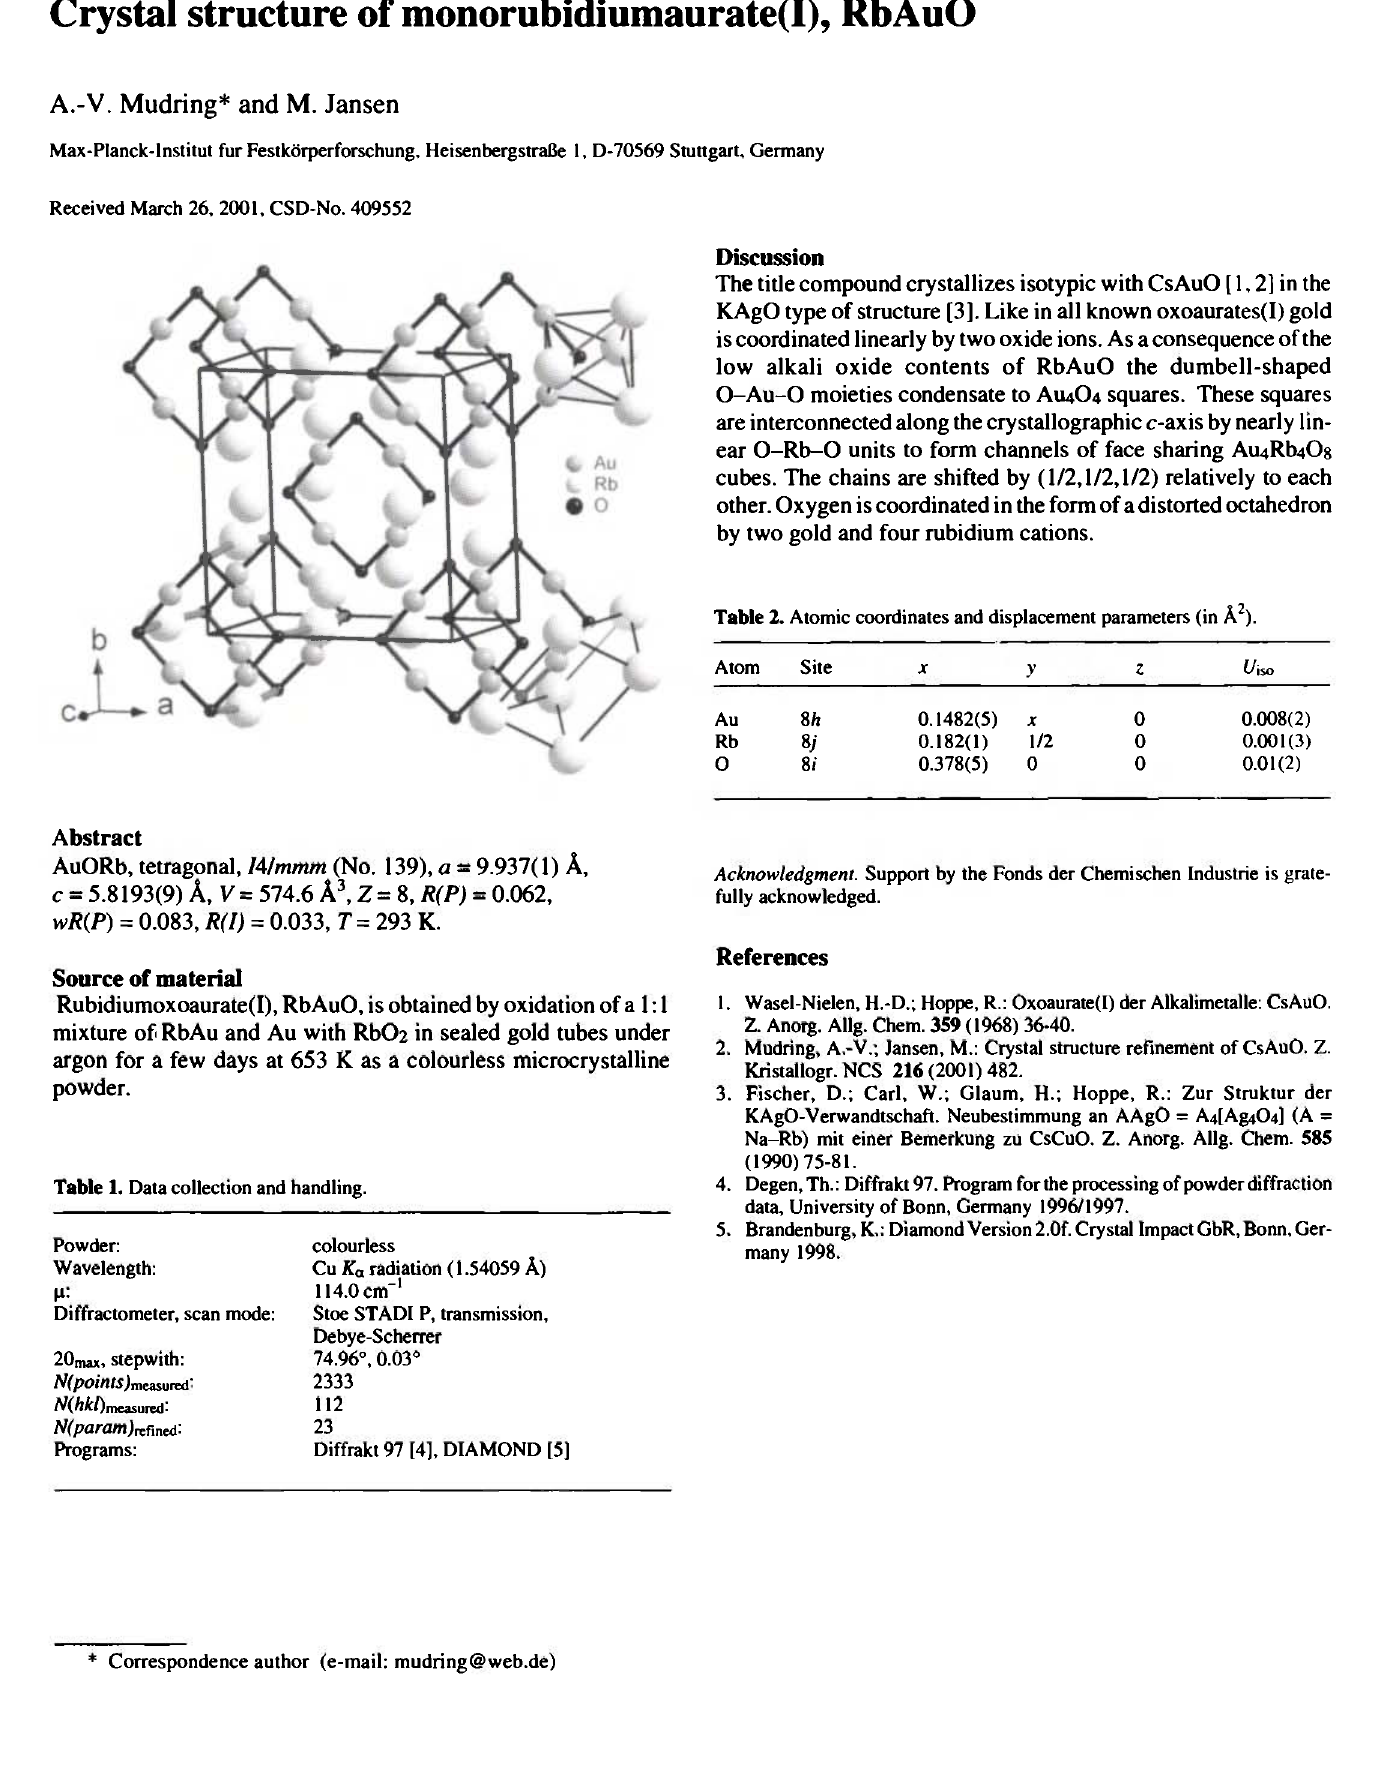
Table 2. Atomic coordinates and displacement parameters (in Ä 2 ).